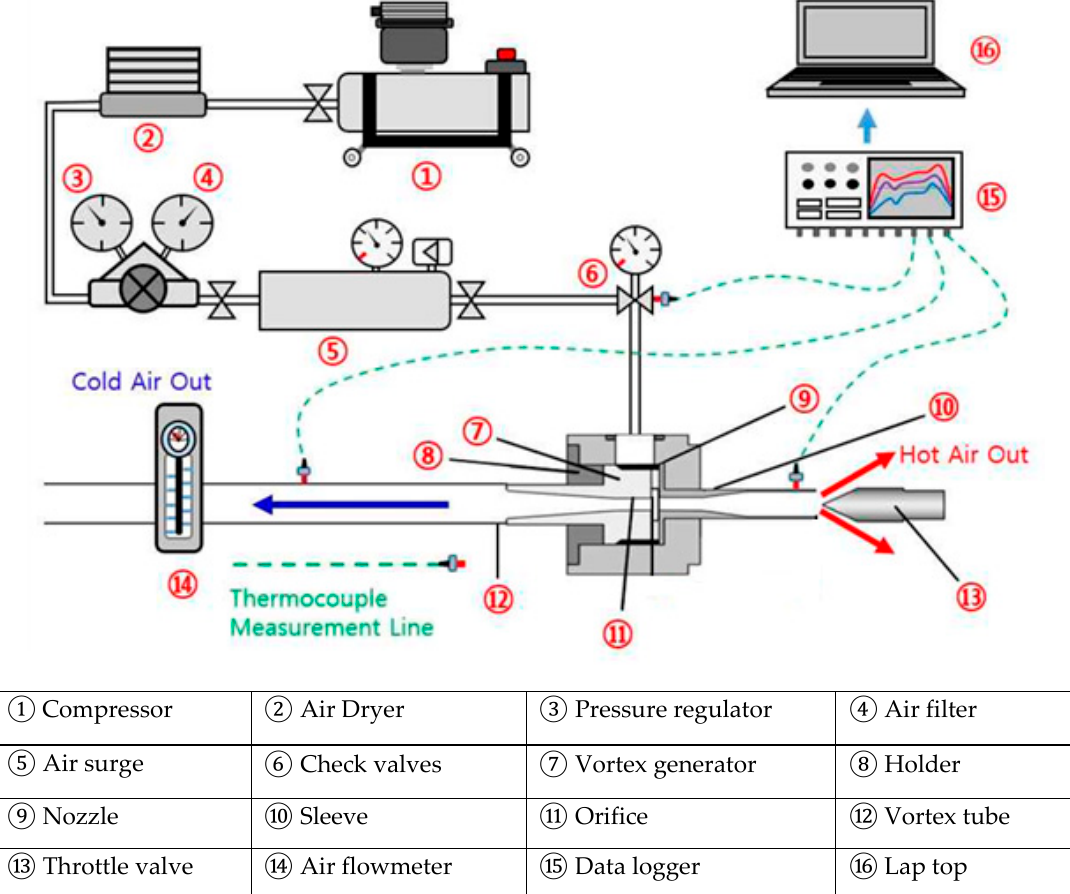
Figure 3. Schematic diagram of the vortex tube system.